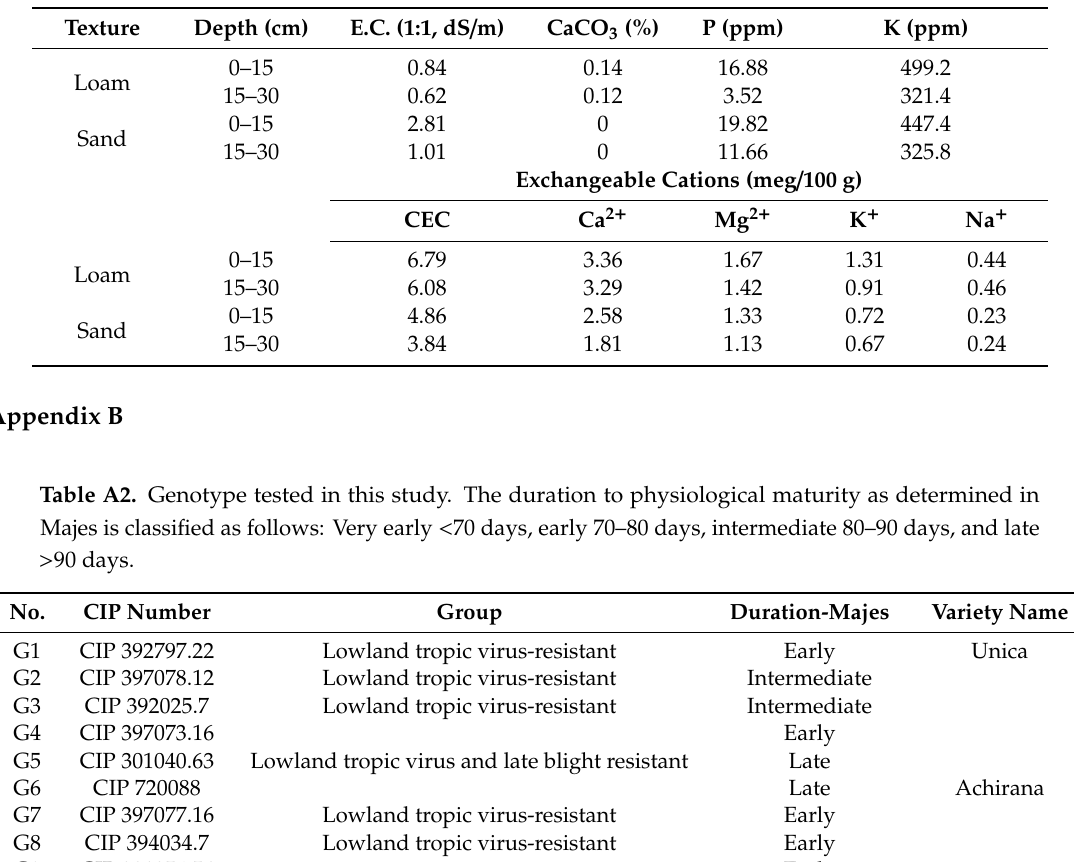
Table A1. Chemical soil analyses.